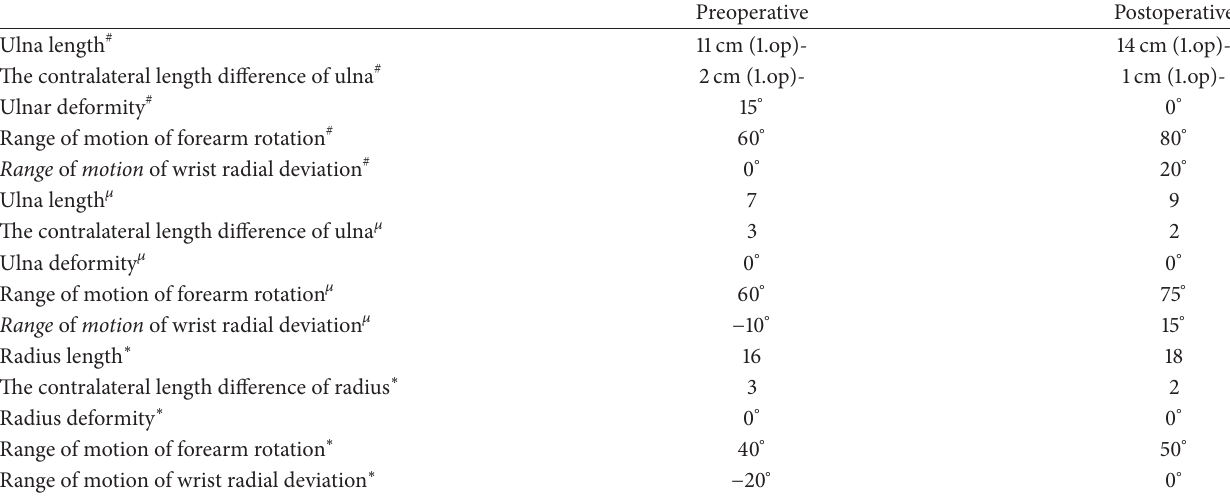
Table 2: Preoperative and postoperative